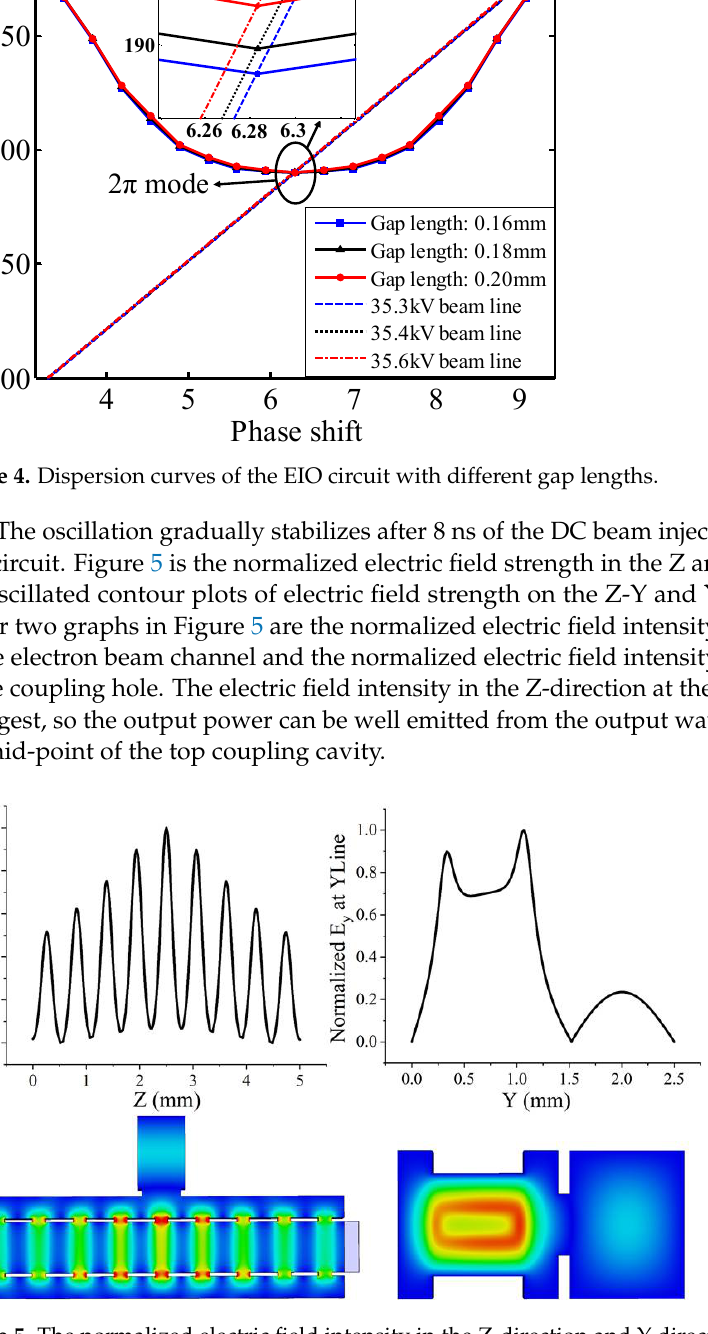
Figure 5. The normalized electric field intensity in the Z-direction and Y-direction and the oscillated